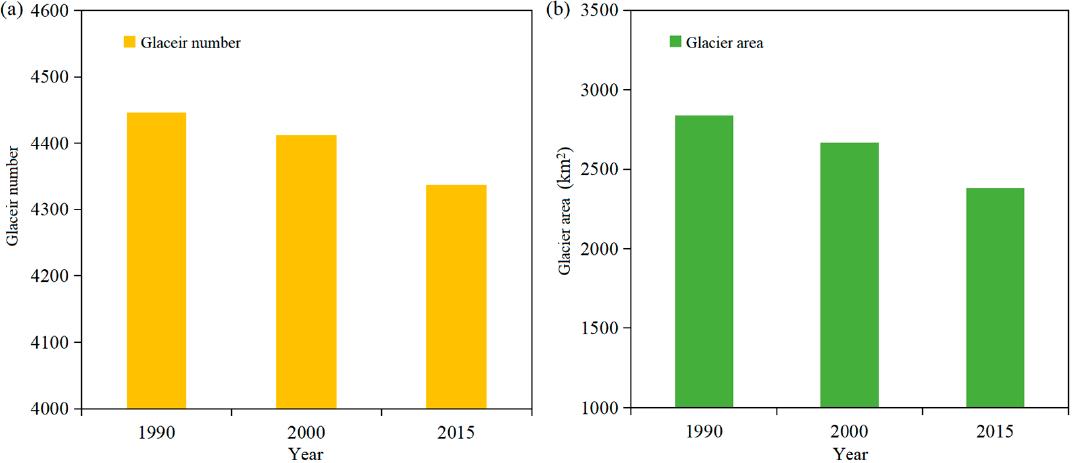
Figure 3. Changes in glacier number ( a ) and area ( b ) in the northern Tien Shan during the period 1990–2015.